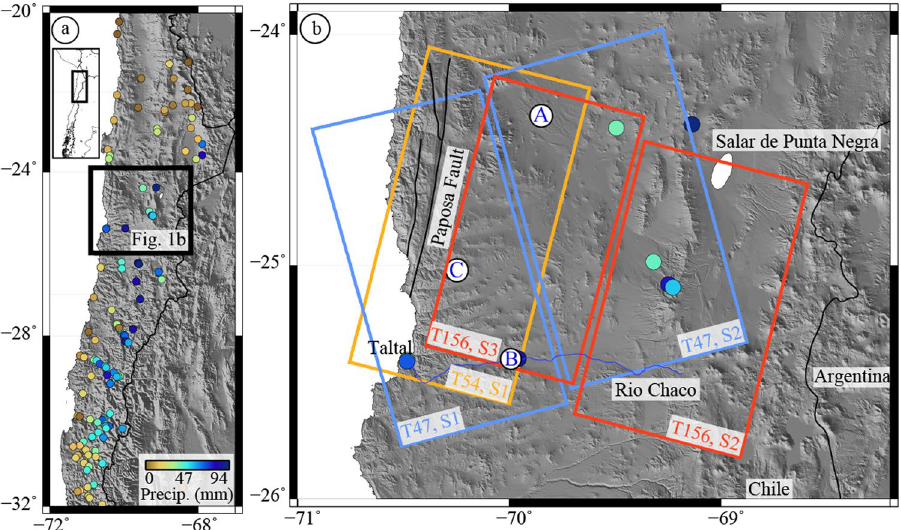
Figure 1. Study location and March 2015 precipitation. ( a ) Extent of the extreme precipitation event as measured at rain gauges (colored dots), overlain on shaded relief. ( b ) Location of Sentinel-1A imagery used here (boxes with track (T) and swath (S) indicated, colored by track), city of Taltal, and locations of time series shown in Figs 3 and 4 (white dots with letters, A: alluvial fan, B: along Rio Chaco, C: location in Coastal Cordillera). Figures generated using Generic Mapping Tools 50 , v. 5.2.1.